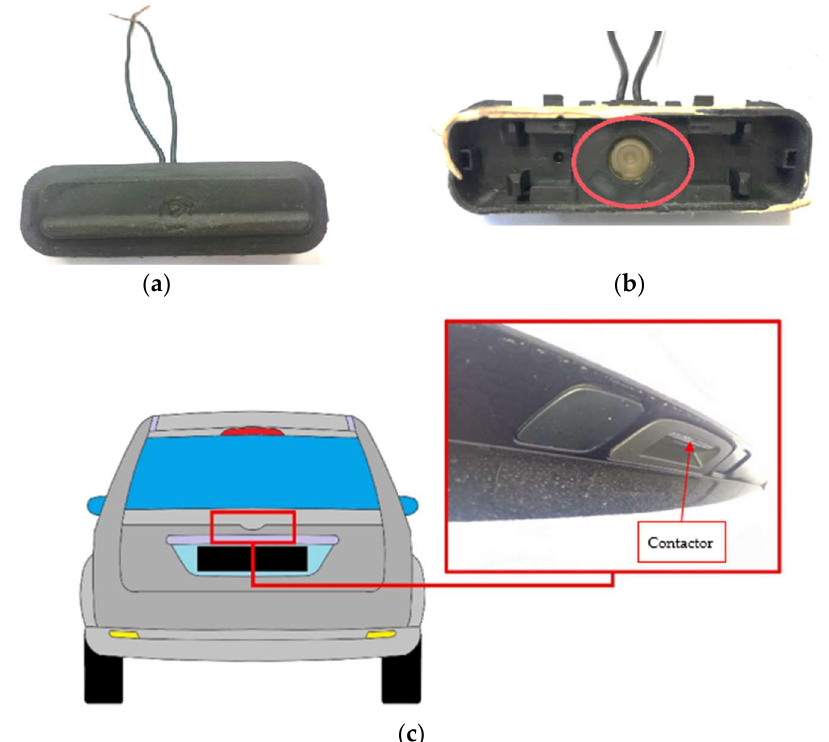
Figure 1. Boot lid contactor; ( a ) front site view, ( b ) front site with an open cover-electronic switch system-button, ( c ) the place where the contactor is located.